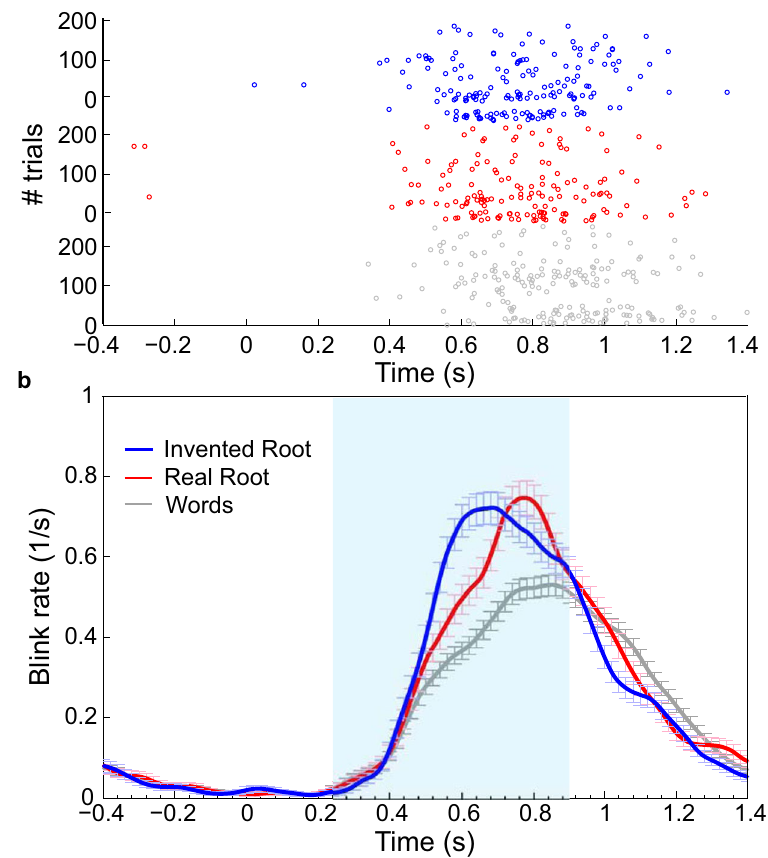
Figure 4. Blink rate modulation. This figure parallels Fig. 2 for blinks. ( a ) Raster plot of blinks of a single subject (female, 24y). Each row represents a single trial, each circle represents a single blink. For visualization, all pseudoword trials (N = 240 trials per condition) but only half of the word trials (N = 240) are displayed. ( b ) Average blink rate modulation. Data were averaged across all trials of all subjects within a condition. Error bars denote standard error of the mean across all trials in each condition. Time zero represents stimulus onset. Shaded blue area illustrates the time window (200–900 ms) used for subsequent